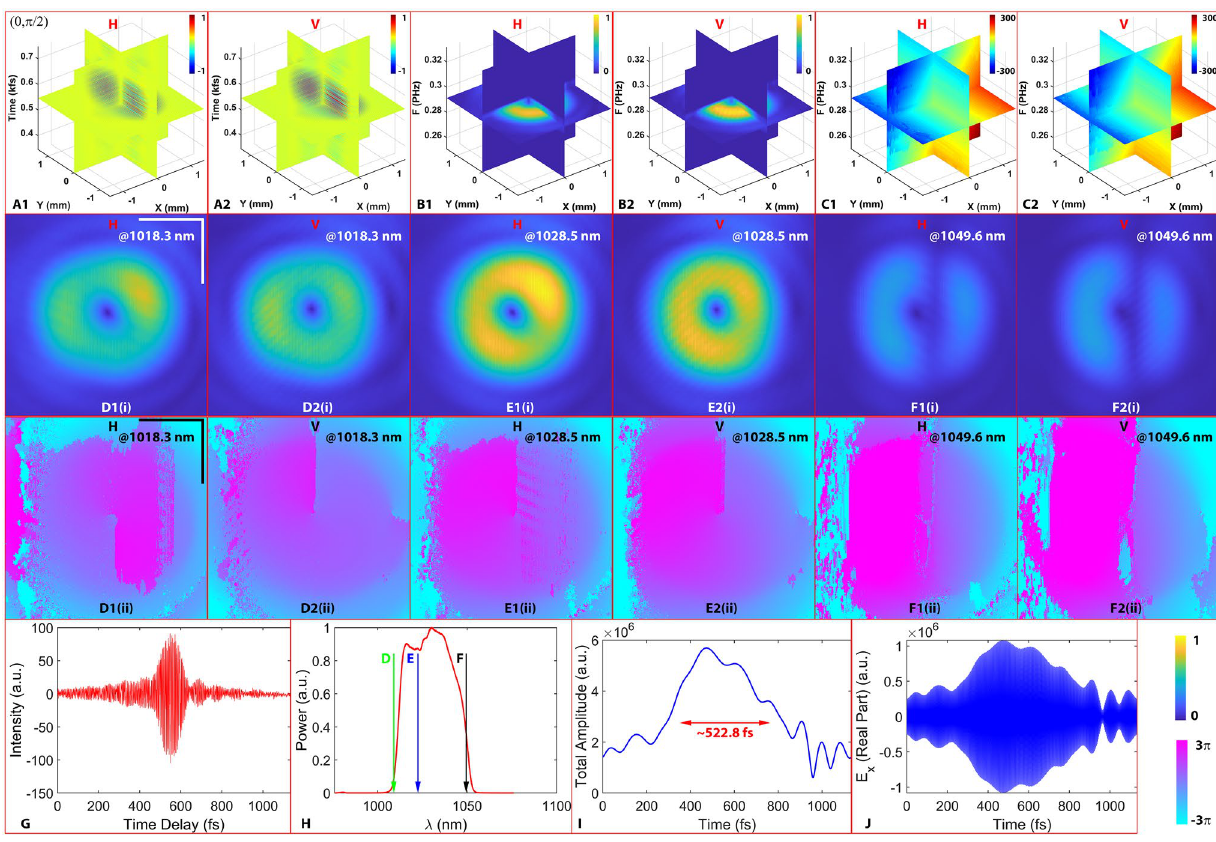
Figure 5. The polarization-sensitive spatiotemporal characterizations of the pulse with north pole state. ( A1-2) : the 3D interferograms of the horizontal ( H ) and vertical ( V ) channels, respectively; ( B1-2) : the corresponding 3D spectral amplitude of the two channels; ( C1-2) : the corresponding 3D spectral phase. ( D) , ( E) , and ( F) : the 2D amplitude (Roman numeral i) and unwrapped phase profiles (Roman numeral ii) at 1018.3 nm, 1028.5 nm and 1049.6 nm, respectively. ( G) : single-pixel cross-correlation signal obtained from the time scanning procedure for H channel; ( H) : the single-pixel spectrum; ( I) : the single-pixel profile for the total temporal amplitude envelope; ( J) : the corresponding real part of the pulse. Scale bars represent 1